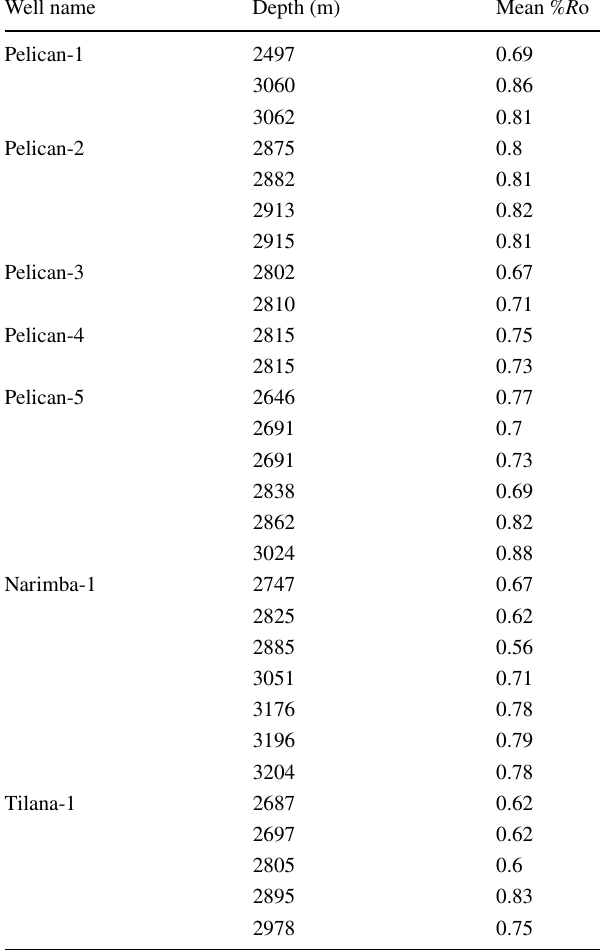
Table 3 Vitrinite reflectance data for the Narimba Formation within the wells Pelican-1 to 5, Narimba-1 and Tilana-1